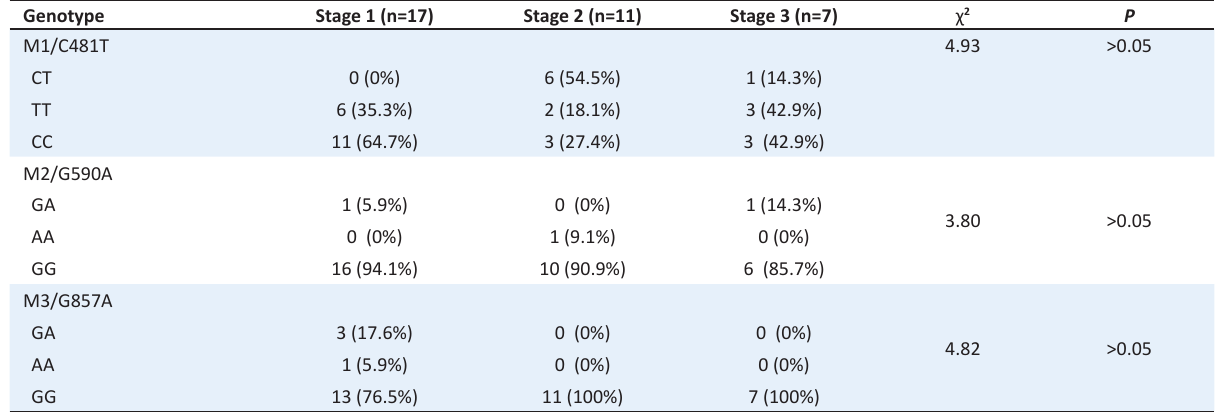
Table 3. Statistical comparison of NAT2 gene polymorphism (M1, M2 and M3) among different pathological stages of bladder cancer patients using chi- square test